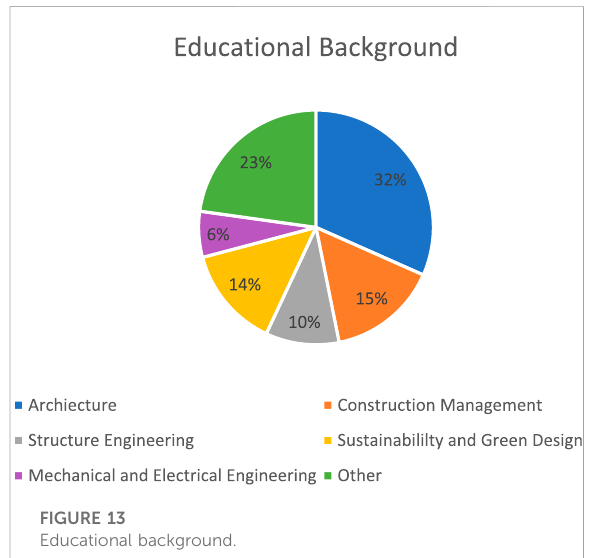
FIGURE 13 Educational